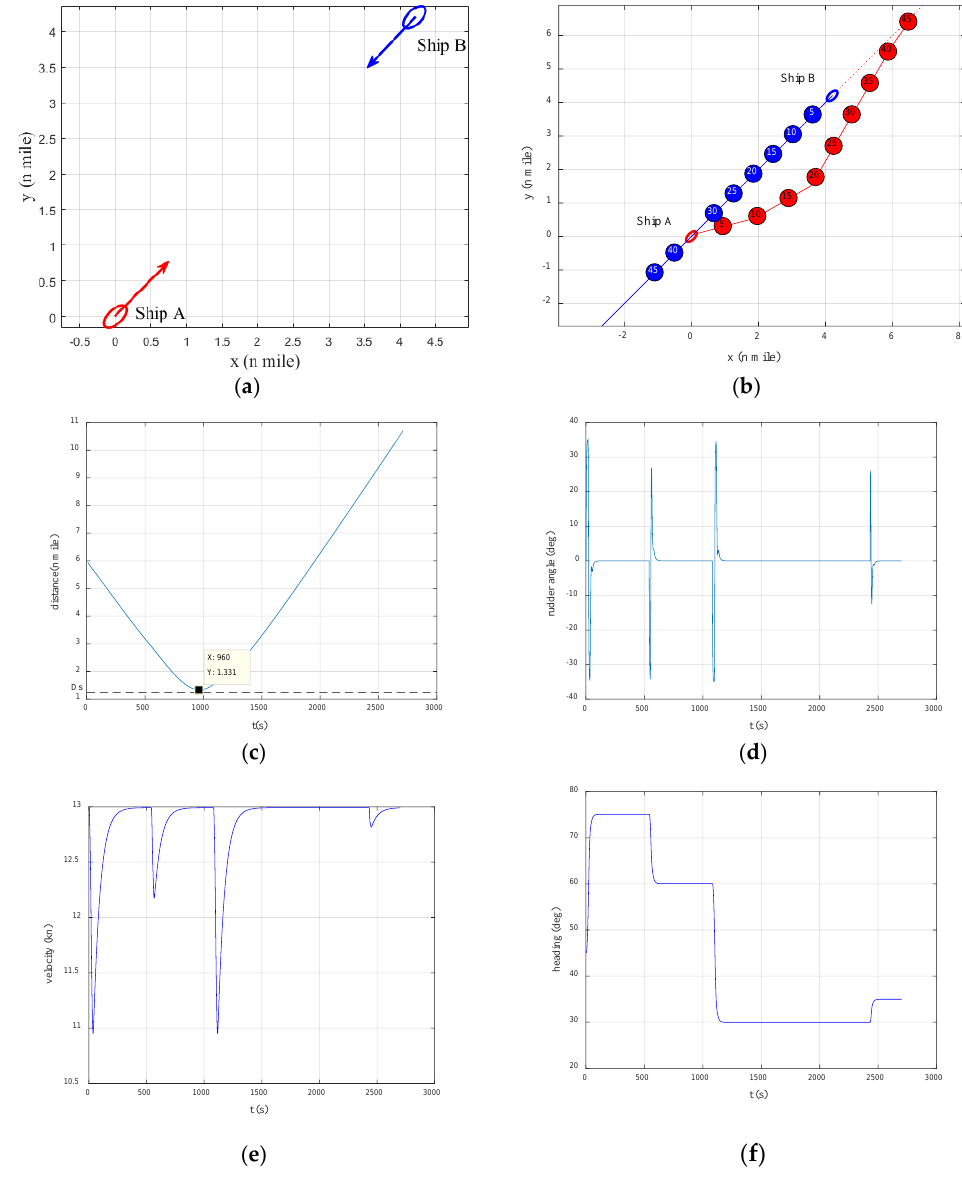
Figure 10. Simulation results for a head-on situation. ( a ) Initial traffic configuration; ( b ) optimal